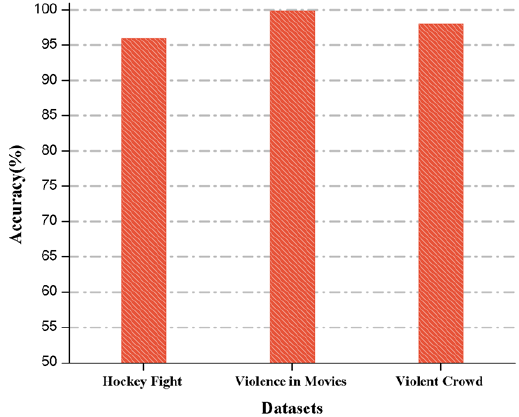
Figure 9. Comparative analysis of the proposed method on various datasets based on accuracy.